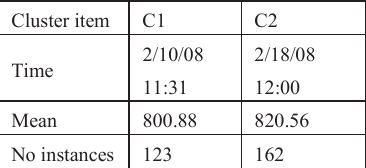
Table 3. Cluster means for Stage